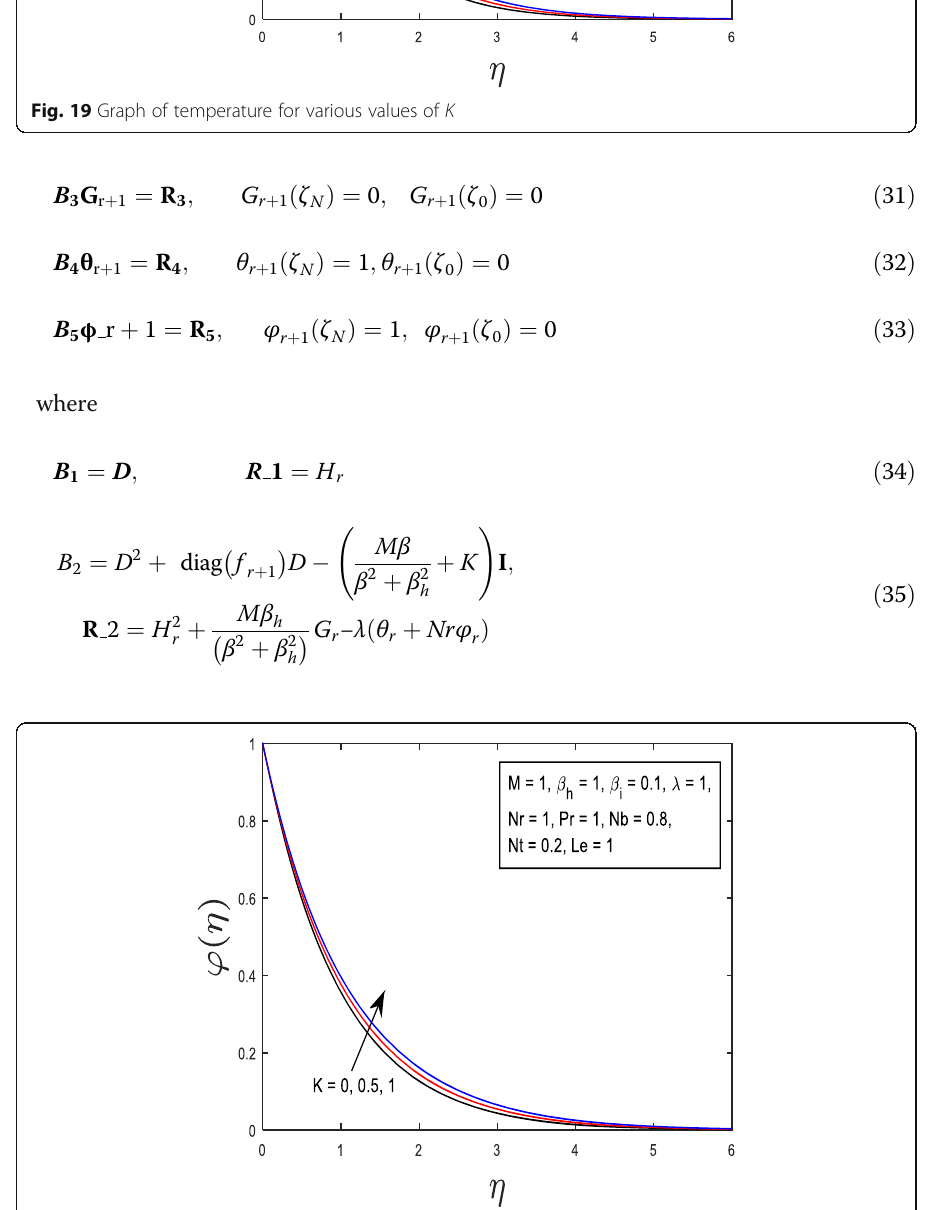
Fig. 20 Graph of concentration for various values of